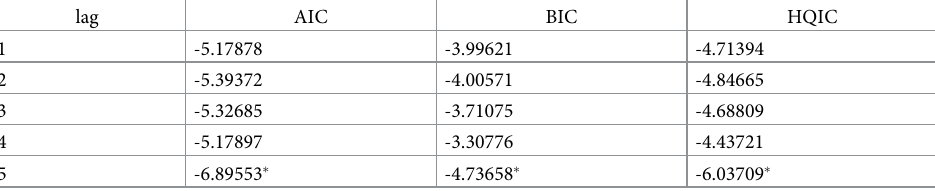
Table 7. Lag test of PVAR model for logistics industry and the comprehensive technical efficiency of manufactur- ing industry.